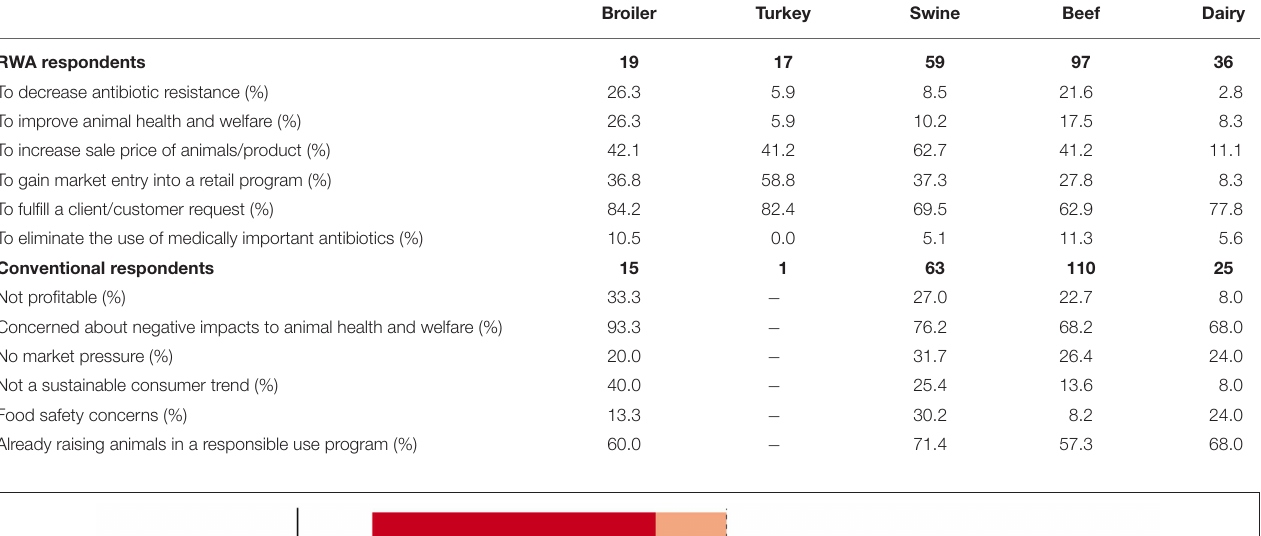
TABLE 2 | Factors contributing to decision to raise animals RWA or conventionally, n = 442.